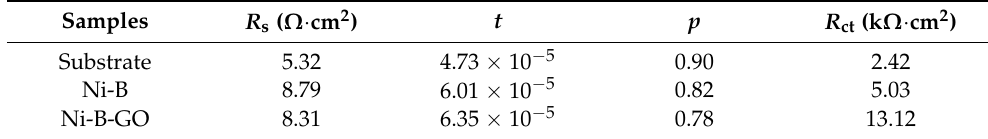
Table 3. EIS parameters determined for the